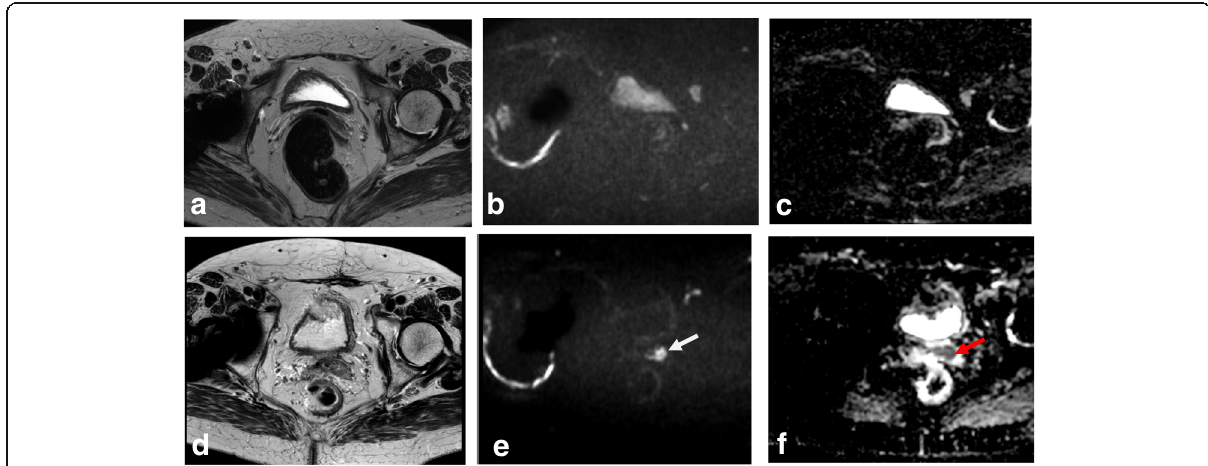
Fig. 1 MRI technique artifacts. a Axial oblique T2WI. b , c DWI (b: 1000 and ADC map). Right hip prostheses and rectal air prevent detection of a small cervical tumor. d – f Axial oblique T2WI and DWI. After rectal air removal and change of phase direction, a tiny cervical cancer tumor is visible (arrows)